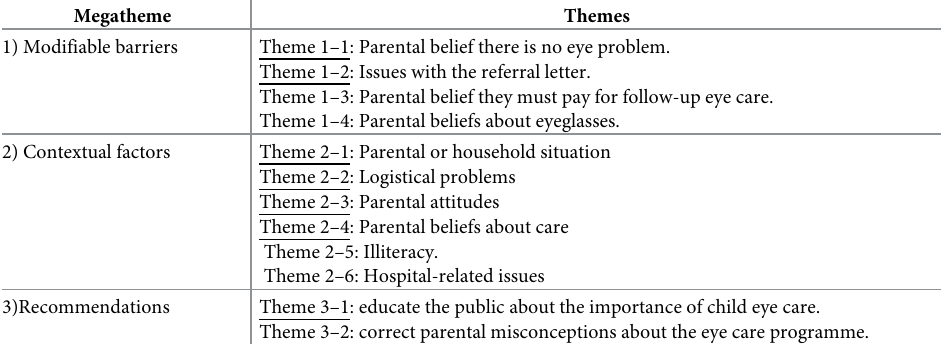
Table 3. Megathemes and themes derived from 10 focus group